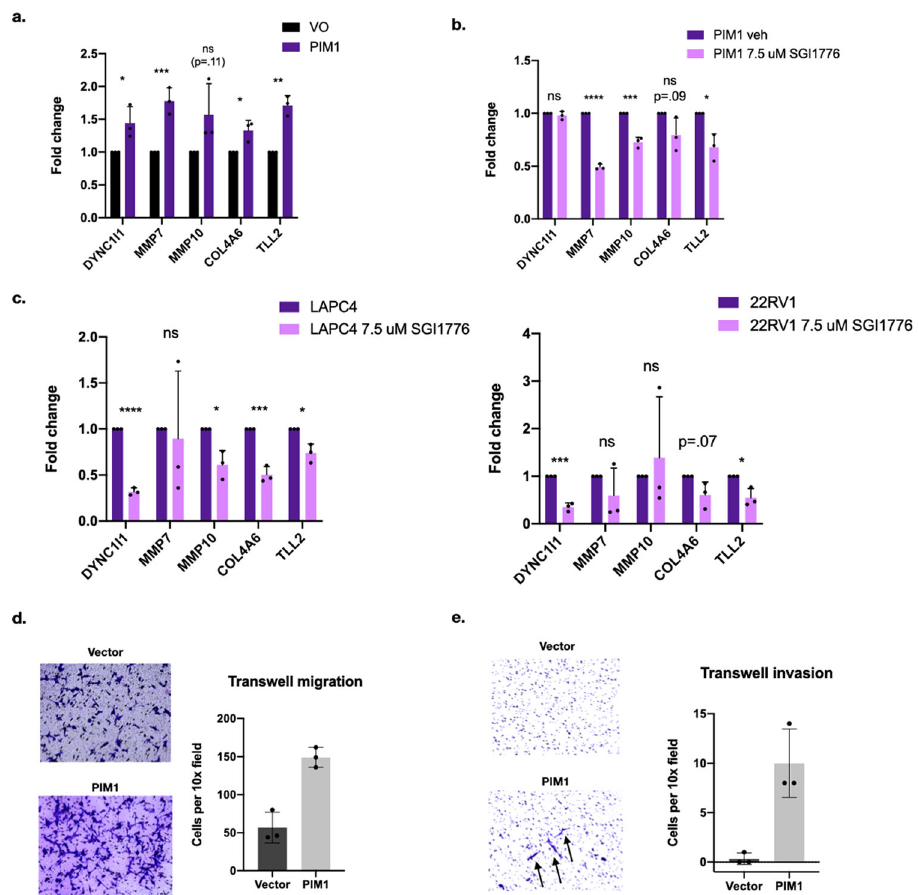
Fig. 4 PIM1 over-expressing LNCaP cells show increased expression of genes involved in invasion and metastasis. a Validation of increased expression of genes identi fi ed in RNA sequencing in PIM1 over-expressing cells (DYNC1I1: 1.44 + / − 0.25, p = 0.038. MMP7: 1.78 + / − 0.20, p < 0.0027.